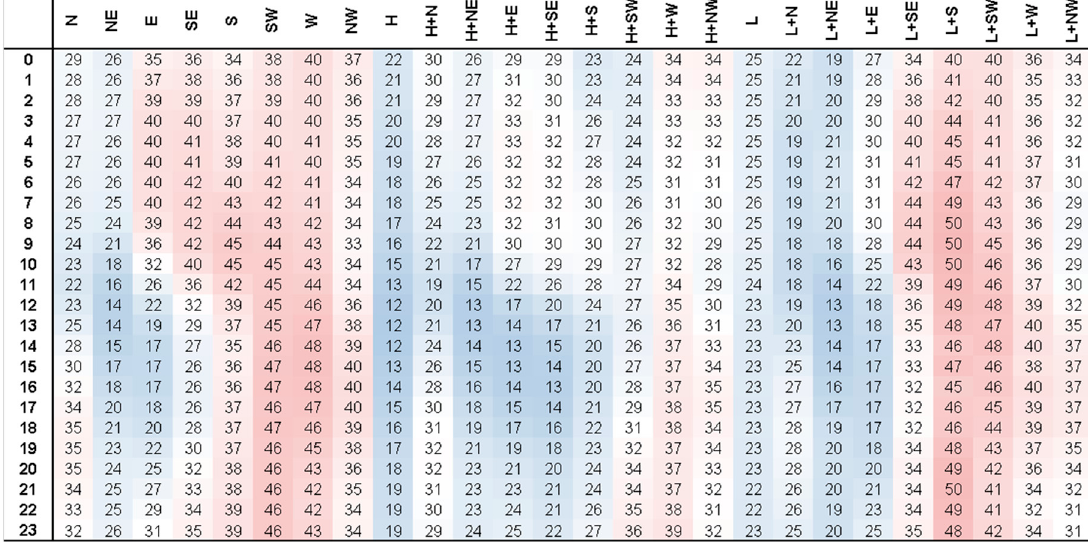
Figure 10. Average hourly wind power capacity factor (%) according to the different weather regimes.